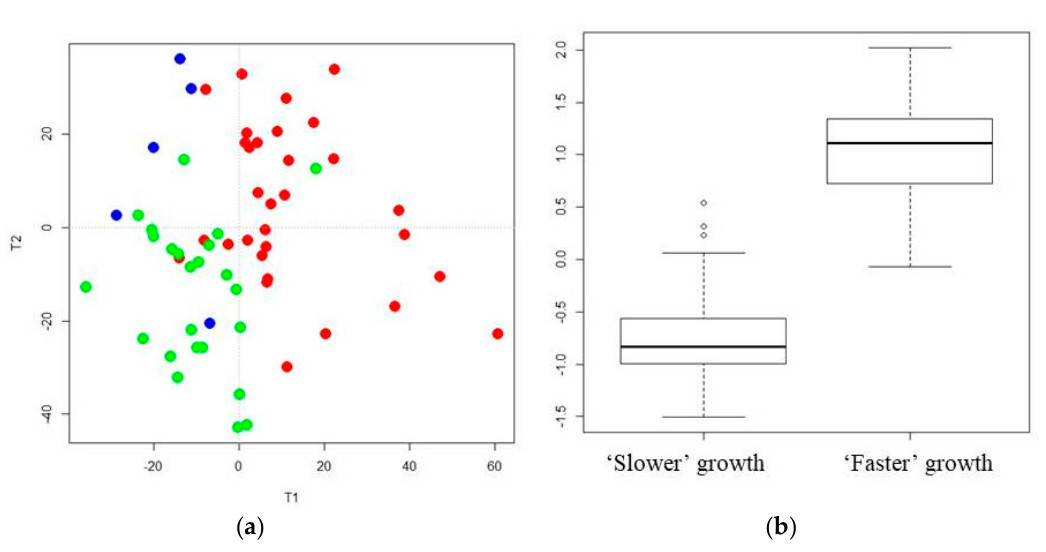
Figure 4. AoV-PLS and LDA models, based on the LC-ESI + -HRMS profiles of human preterm milk, on the factor weight Z -score (discharge-birth): AoV-PLS score plot with 45% of variance (R2Y = 38%) on: components 1–2 ( a ); and LDA (built on 10 components of AoV-PLS) with a p -value = 0) ( b ). Breast milk provided to preterm infants who experienced “faster” (green) or “slower” (red) growth and to twin infants with discordant growth rate, one with high growth rate and one with low growth rate, (blue).